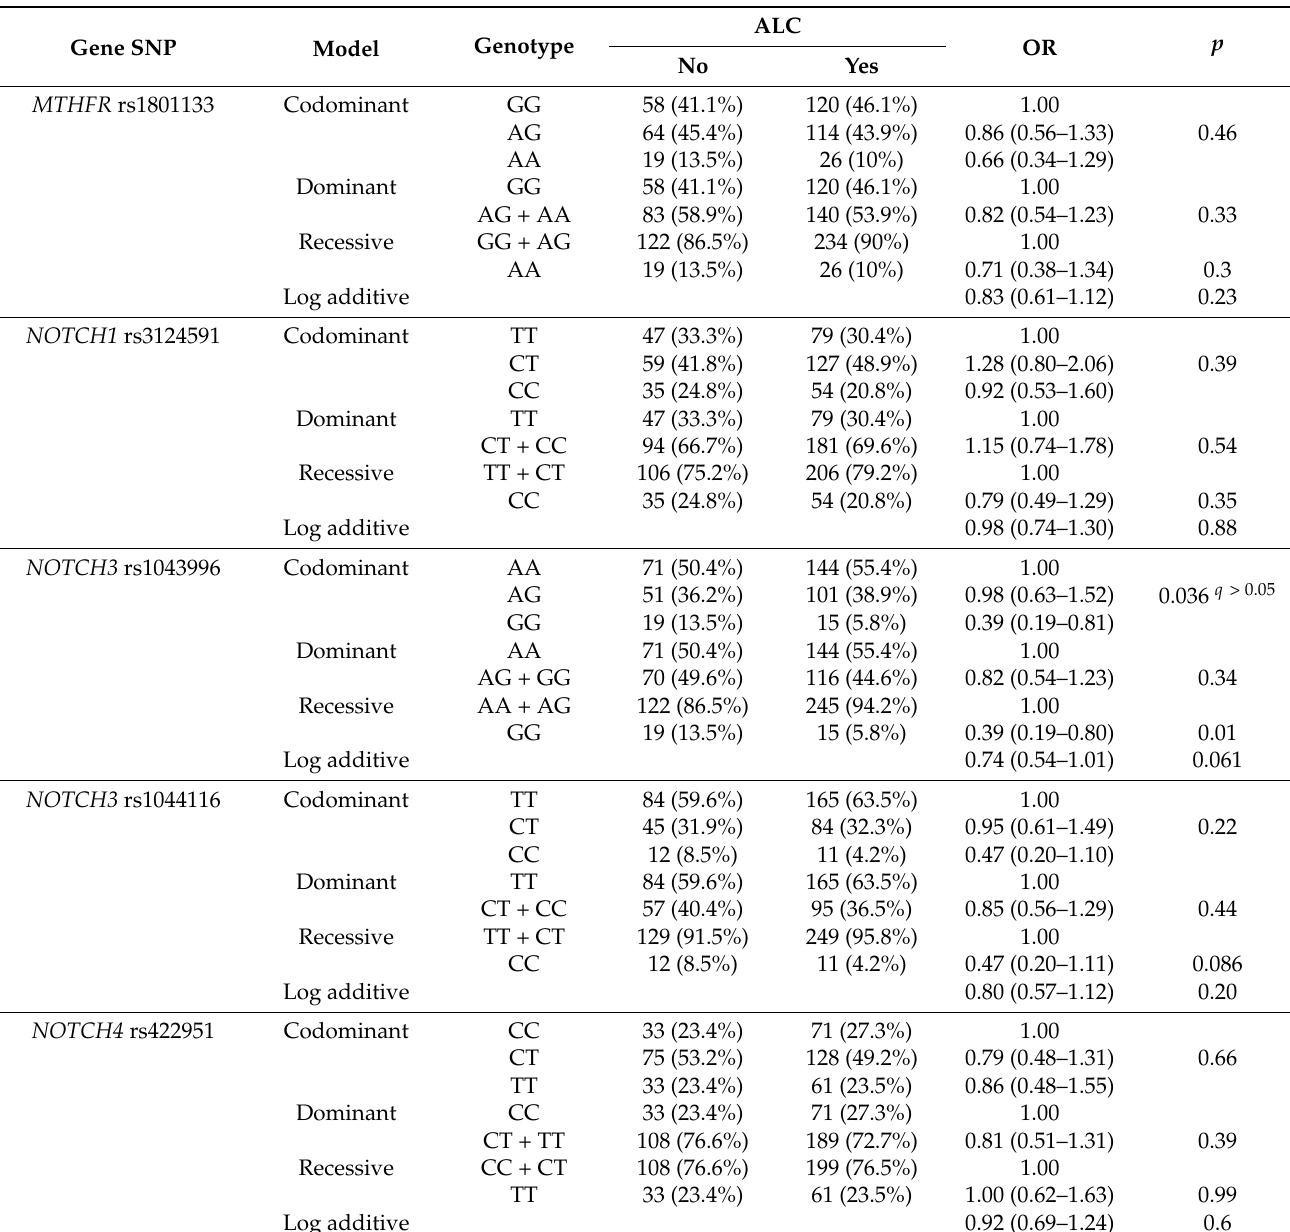
The independence of predictors was further analyzed by multiple logistic regression. All three SNPs remained significantly associated with the susceptibility to cirrhosis, even after additional model adjustment for sex and age (Table